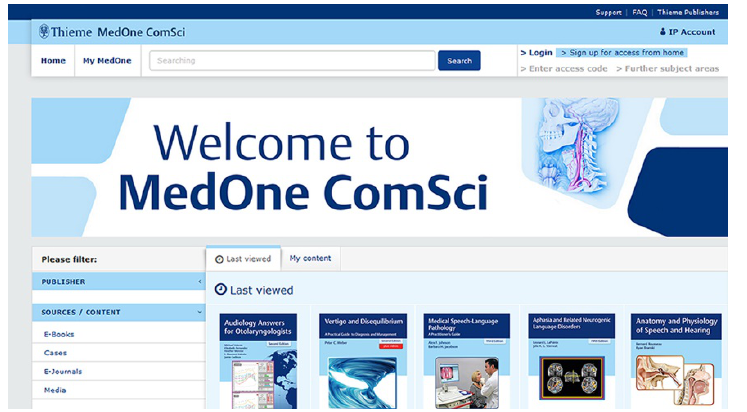
Figure 1 Thieme MedOne ComSci home